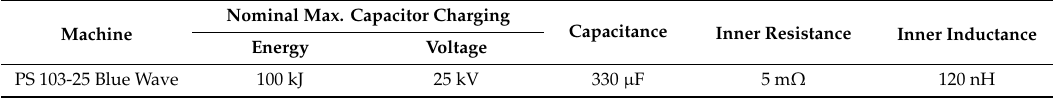
Table 3. Characteristics of the pulsed power generator PS 103-25 Blue Wave available at Fraunhofer